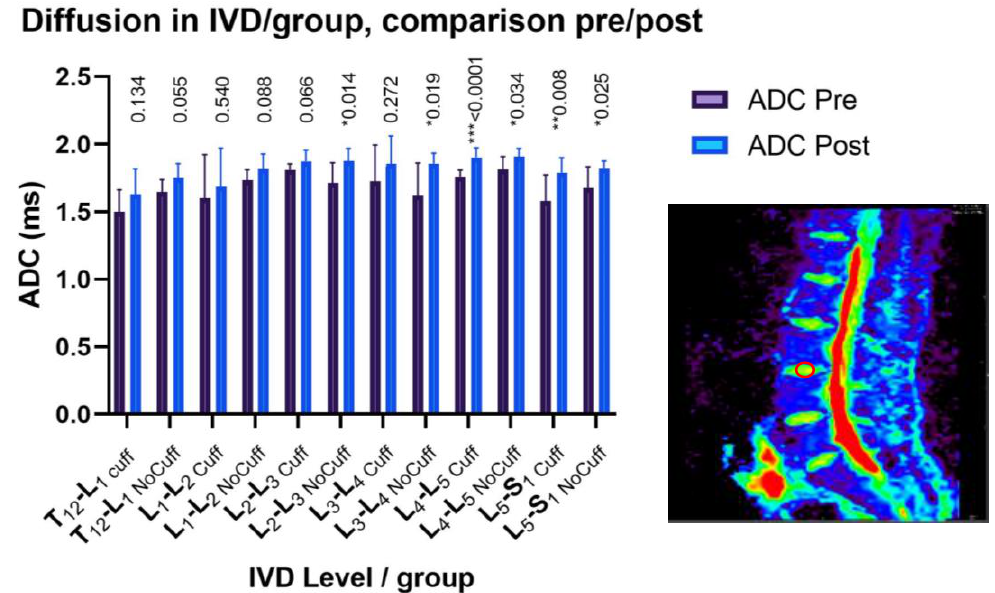
Figure 4. Apparent diffusion coefficient (ADC) in lumbar intervertebral discs (IVD) from the MRI sagittal view (region of interest in red circle inside IVD L3-L4). All of the lumbar levels significantly increased in water content after dry immersion (* p < 0.05; ** p < 0.01; *** p < 0.001). There were no statistical differences between the Cuffs and Control groups ( p = 0.92).